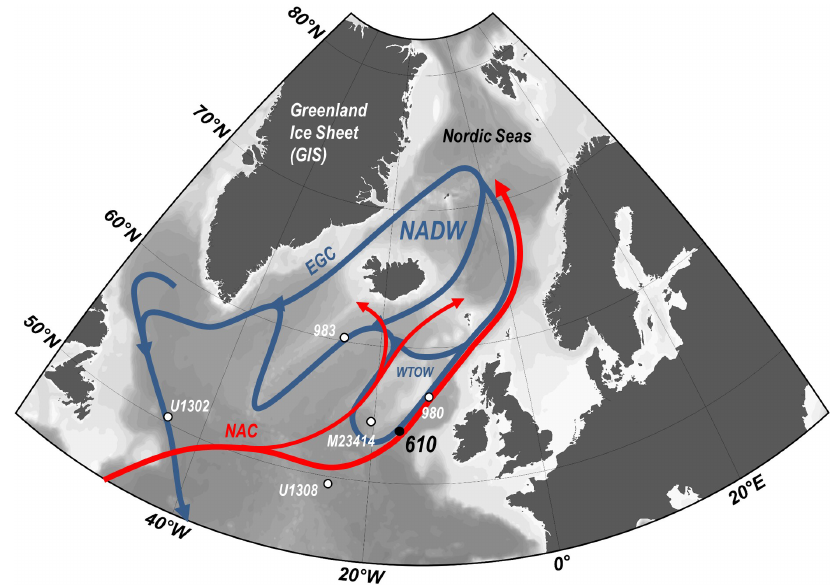
Figure 1. Regional context of the study area. Schematic representation of the North Atlantic Ocean and Nordic Seas with arrows indicating the circulation components of the Atlantic Meridional Overturning Circulation (AMOC) in the North Atlantic basin. Major ocean currents include the North Atlantic Current (NAC, in red) and the deep water originating in the Nordic Seas (NDW, in blue). Also shown are the locations of the East Greenland Current (EGC); DSDP site 610 (this study); ODP site 980; ODP site 983; and IODP sites 303-1302, 303- U1308, and site M23414. This figure was generated using Ocean Data View software (http://odv.awi.de/, last access: 20 July